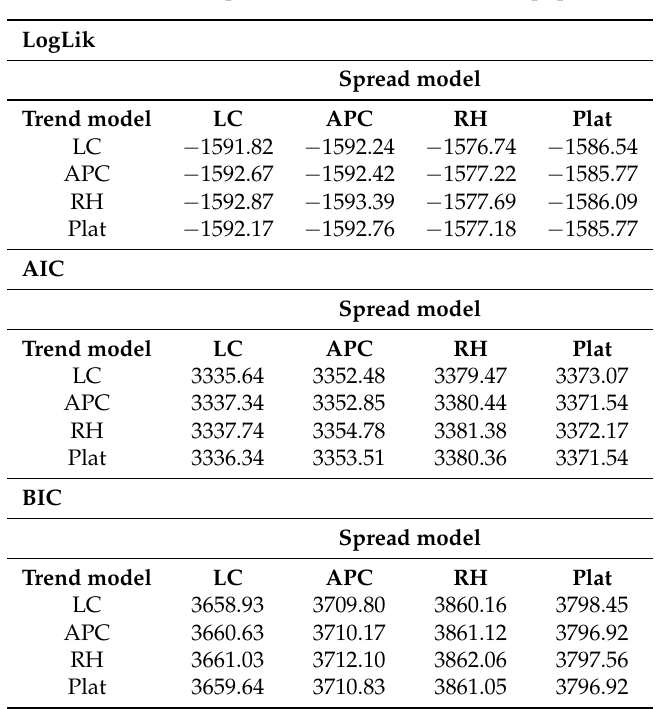
Table 6. Models comparison for the female Maltese